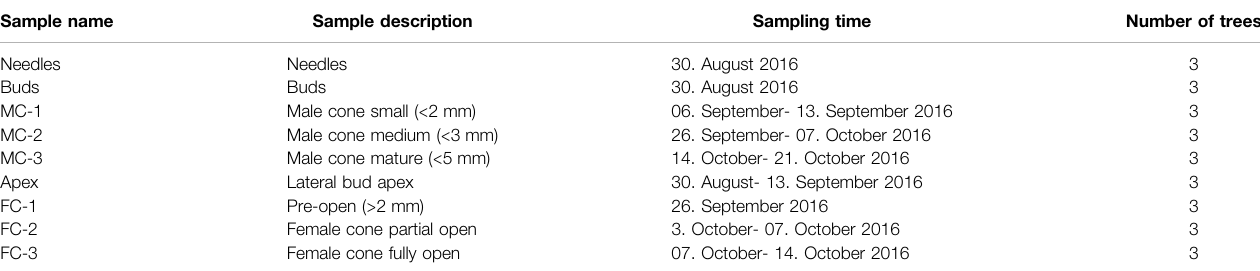
TABLE 1 | P. densi fl ora tissue collections. MC: male cones, FC: females